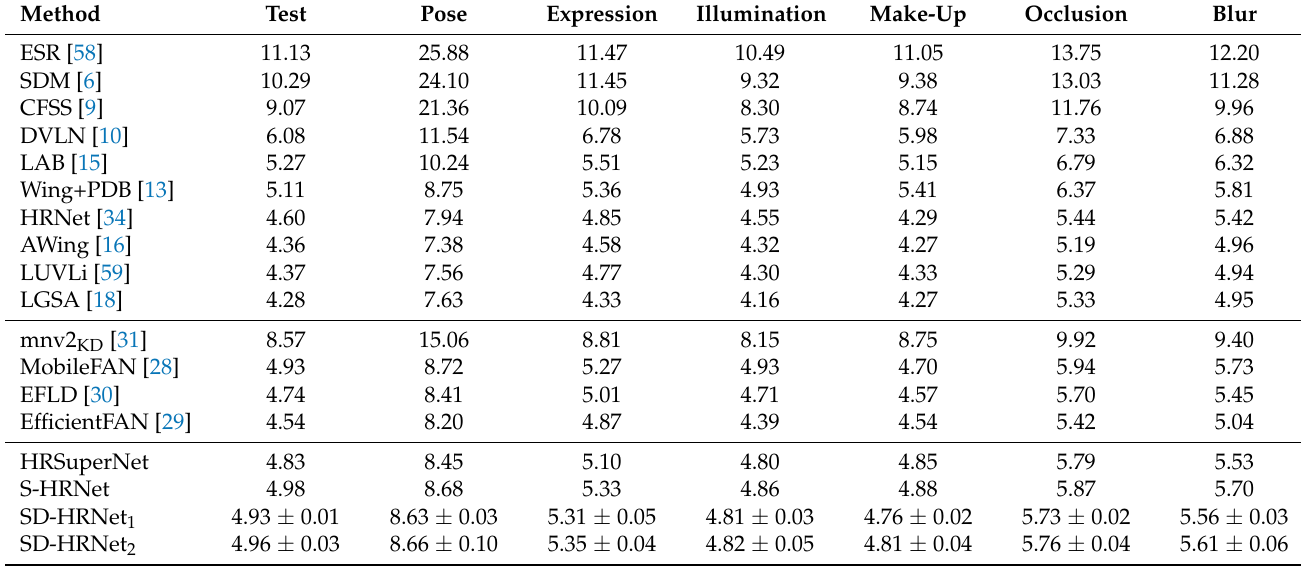
Table 5. Comparison of NME (%) on the WFLW test set and 6 subsets: pose, expression, illumination, make-up, occlusion, and